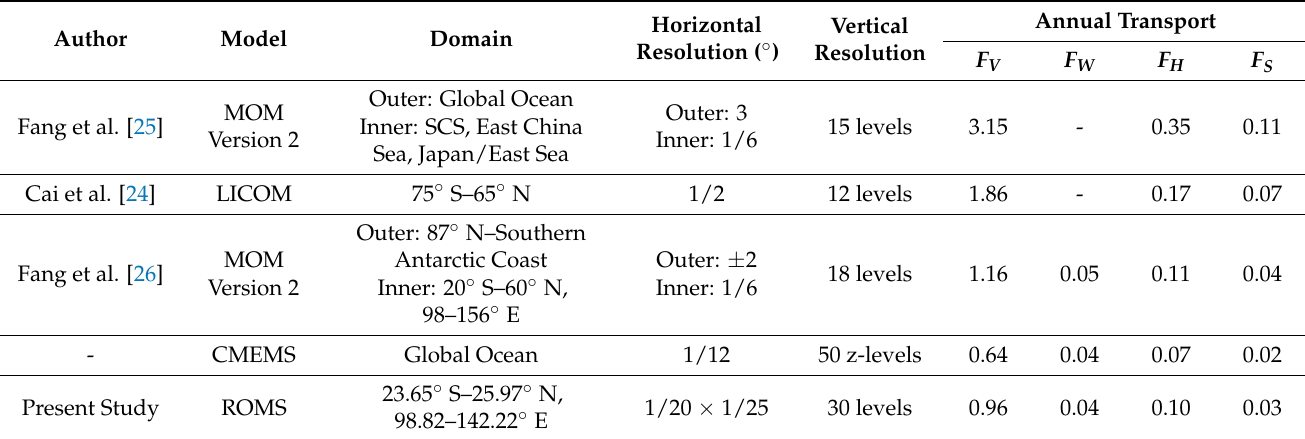
Table 1. Previous and current estimation of annual volume ( F V ; unit: 10 6 m s − 1 ), freshwater ( F W ; unit: 10 6 m s − 1 ), heat ( F H